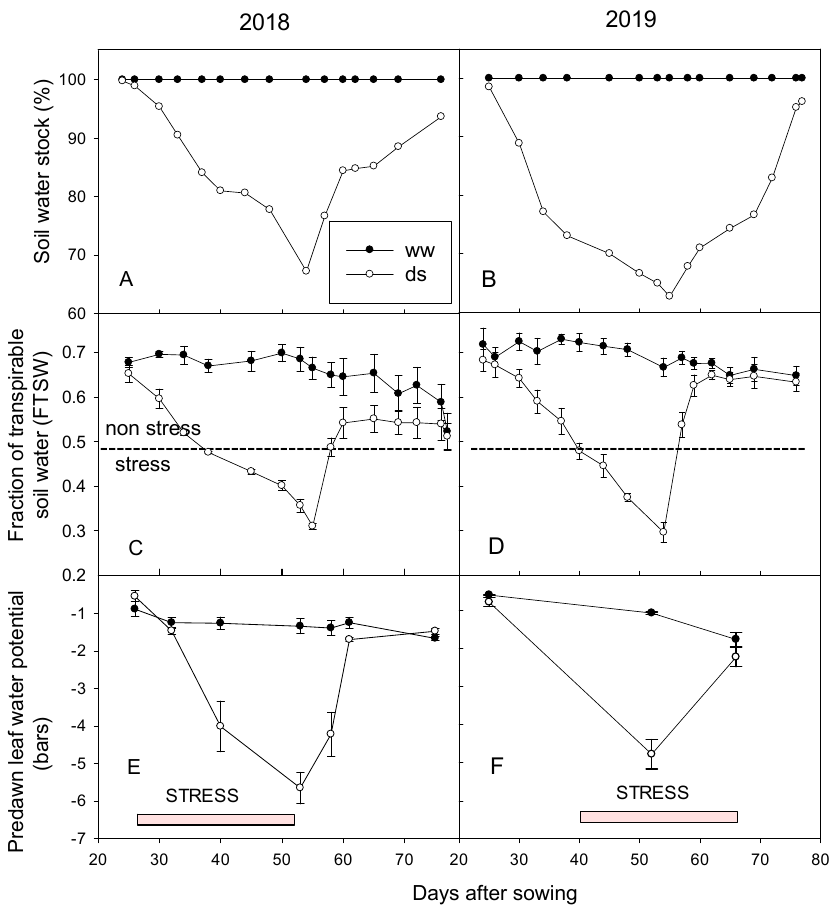
Figure 2. Evolution of soil moisture stock (%) for 2018 ( A ) and 2019 ( B ), fraction of transpirable soil water for 2018 ( C ) and 2019 ( D ) and predawn leaf water potential (bar) for 2018 ( E ) and 2019 ( F ) compared between well-watered (ww) and drought stress (ds) treatments.